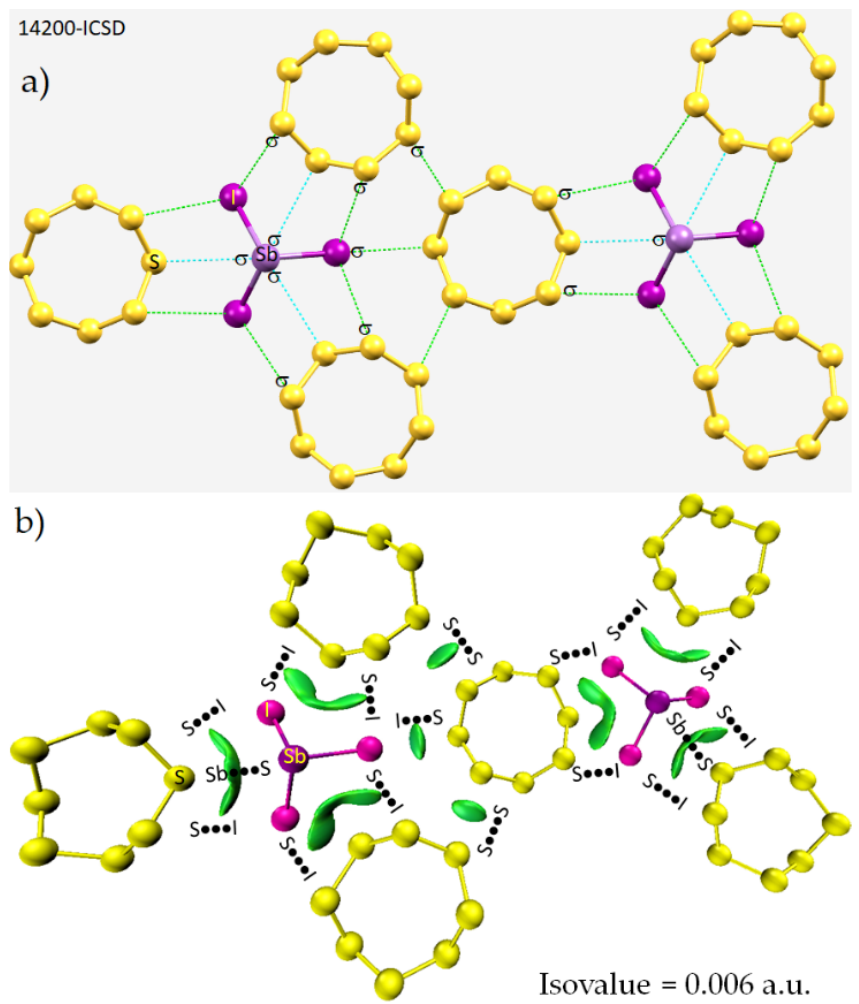
Figure 6. Illustration of various σ -hole centered intermolecular interactions in the crystal structure the adduct SbI 3 :3S 8 . Some molecules in the cell have been deleted for clarity. Shown in ( b ) are the IGM- δ g based isosurface topologies (green) explaining the intermolecular bonding interactions between various interacting atomic domains. The symbol “ σ ” on some atoms in ( a ) signifies the presence of a σ -hole, and the intermolecular interactions are represented by dotted lines in cyan or green. Atom type is shown in each